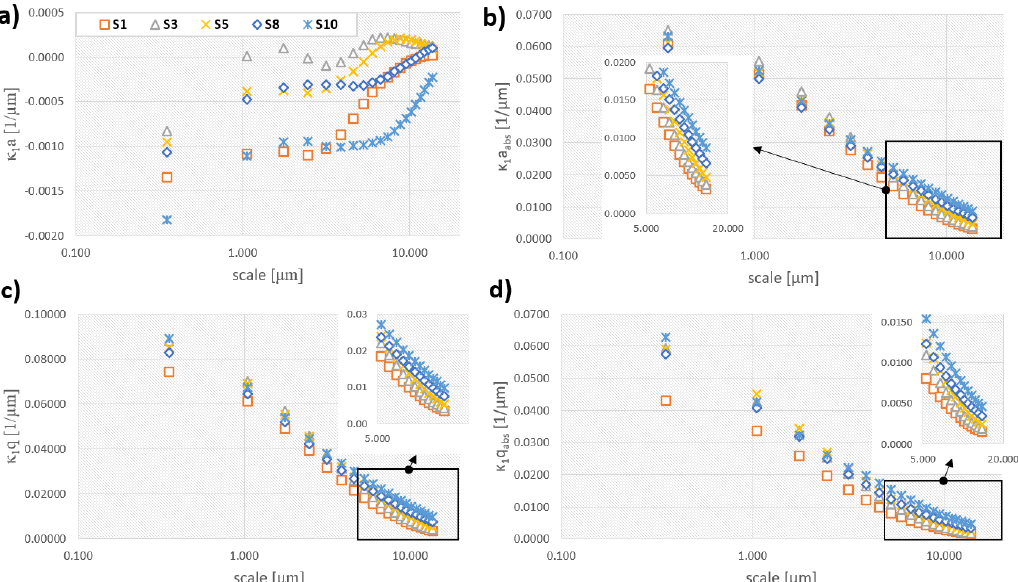
Figure 10. Various statistical parameters related to curvature calculated for surfaces S1, S3, S5, S8 and S10 depicted as a function of scale: ( a ) average of absolute maximum curvature, ( b ) average of absolute maximum curvature, ( c ) standard deviation of maximum curvature, ( d ) standard deviation of absolute maximum curvature.